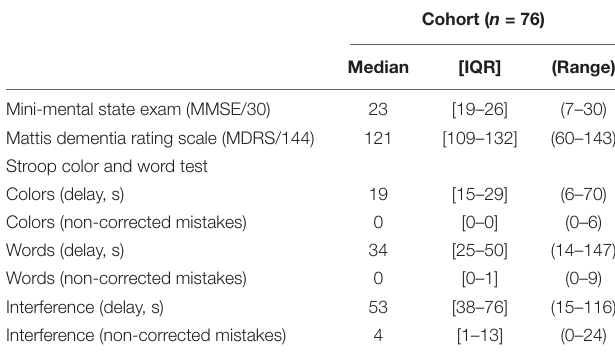
TABLE 3 | Cognitive